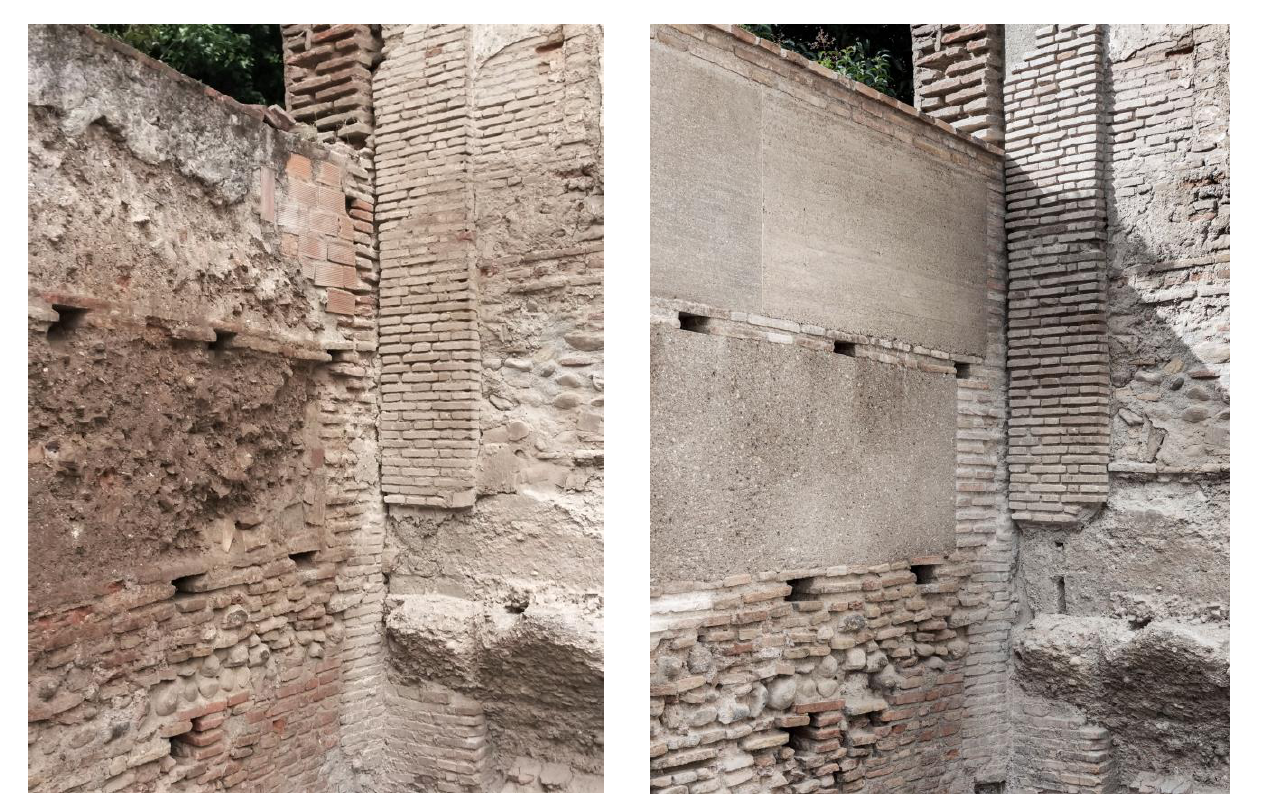
Figure 7. State of preservation of the rammed earth wall before the consolidation works.